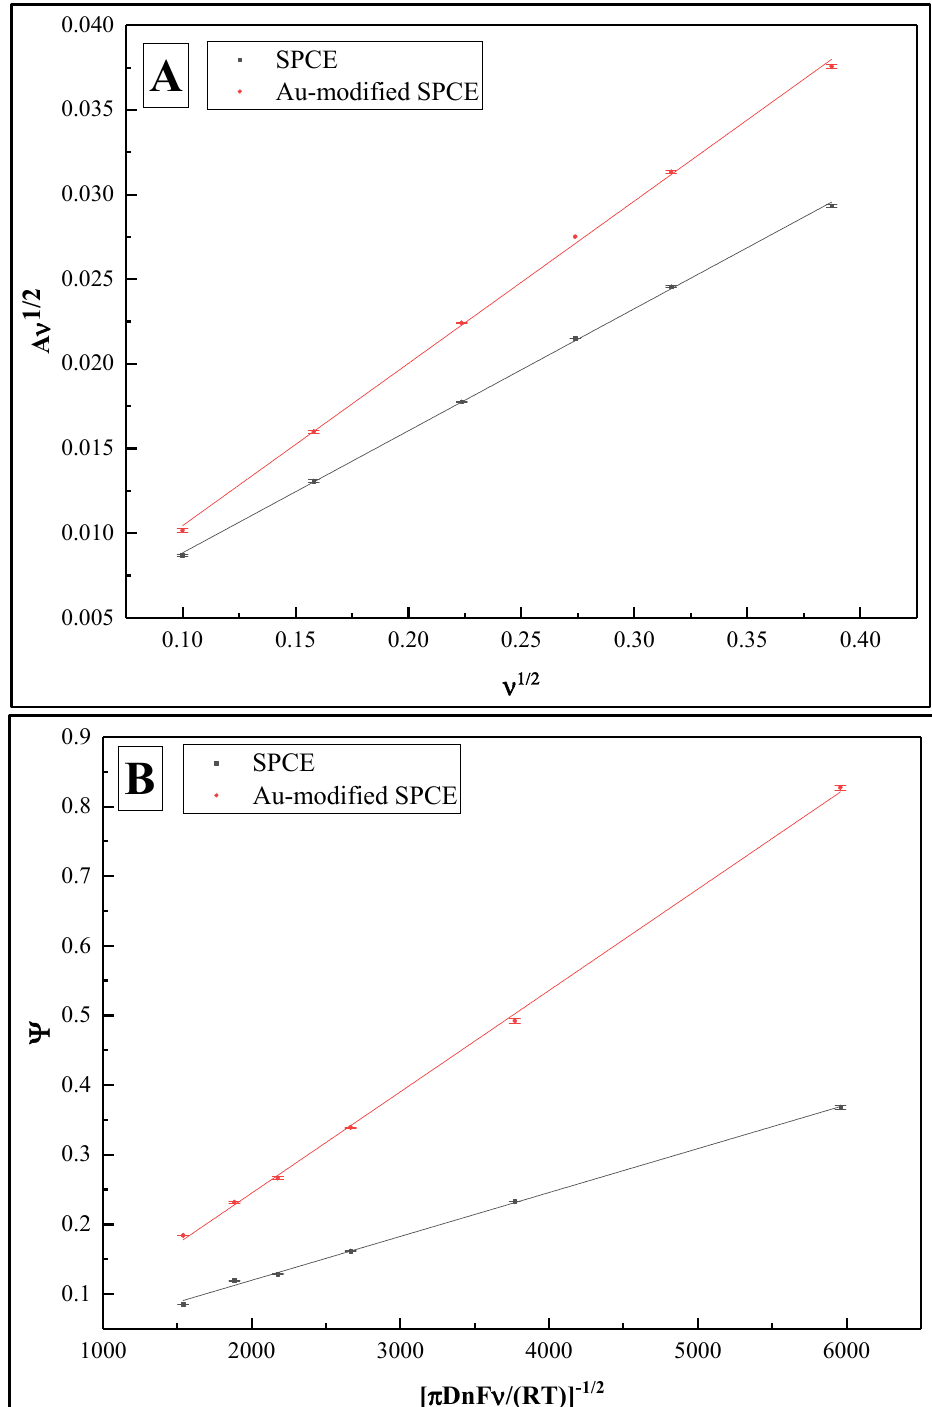
Figure 5. ( A ) Plot of A ν 1/2 vs. ν 1/2 showing calculated electrochemically active surface areas of SPCE and SPCE/AuNS as slopes. ( B ) Plot of Ψ vs. [ π DnF ν /( RT )] − 1/2 showing calculated k 0 values of SPCE and SPCE/AuNS as slopes.